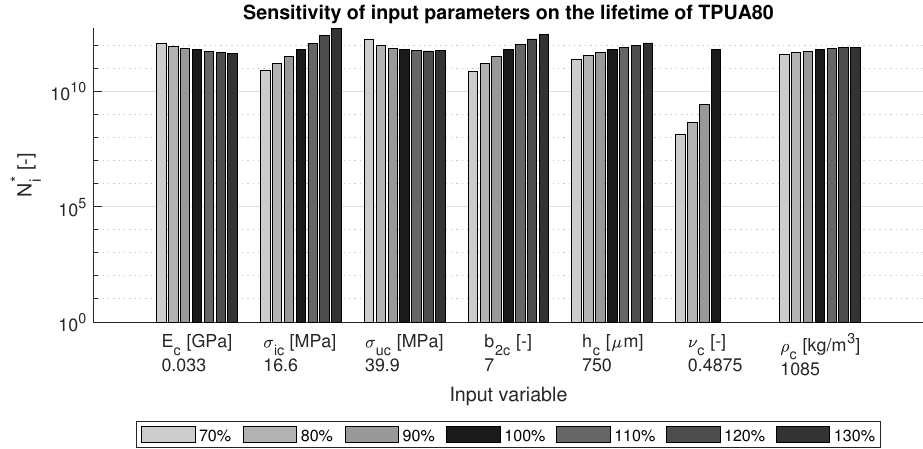
Figure 4. Sensitivity of variations in the input parameters on the lifetime of